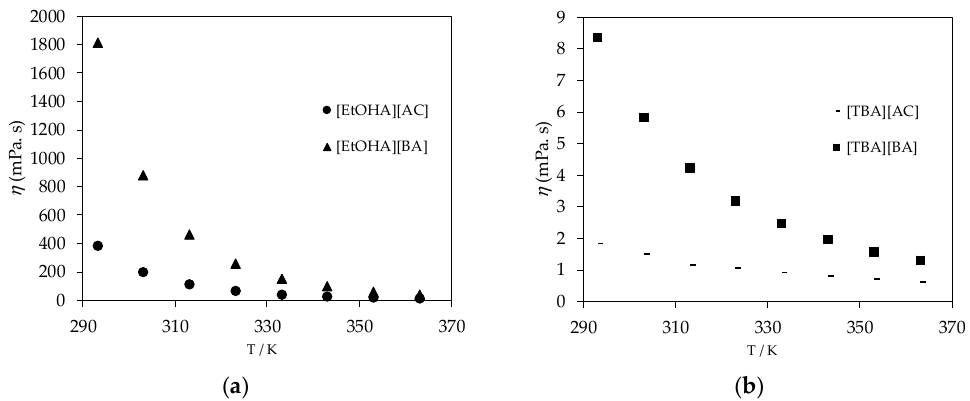
Figure 5. ( a ) plot of experimental viscosity ( η ) values of [EtOHA][AC] and [EtOHA][BA] ionic liquids and ( b ) plot of experimental viscosity ( η ) values of [TBA][AC] and [TBA][BA].